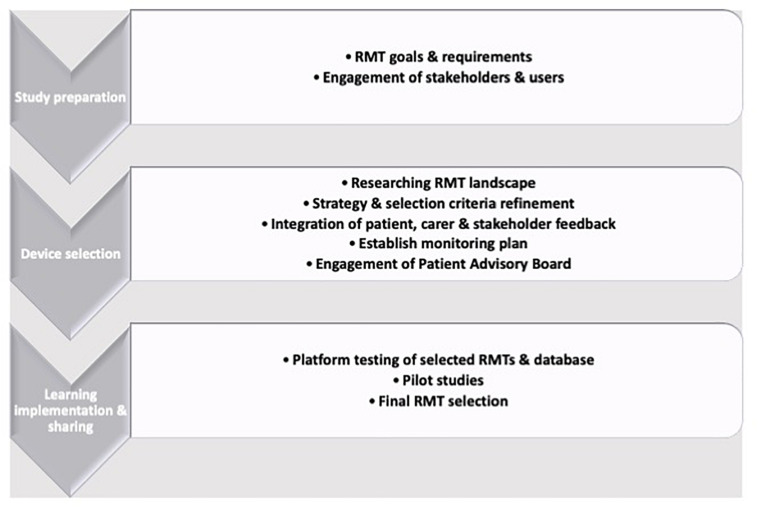
An example of a remote measurement technology device selection framework.